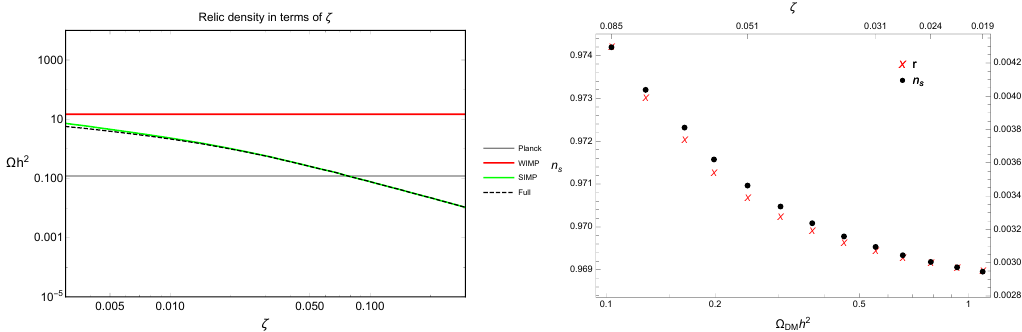
Figure 6 . (Left) Relic densities for each dark matter components as a function of (cid:16) . (Right) Correlation between relic density, spectral index and tensor-to-scalar ratio. The parameters are chosen as follows: sin (cid:18) = 10 (cid:0) 6 , " = 10 (cid:0) 4 , g X = 0 : 1, m h 0 = 0 : 35GeV, m (cid:31) = 0 : 1GeV, (cid:21) (cid:30) = (cid:21) (cid:31) = 0 : 1, (cid:21) (cid:30)(cid:31) = (cid:21) (cid:31)H = 10 (cid:0) 4 , thus m Z 0 = 0 : 235GeV. The grey horizontal solid line on left represents the Planck data for the relic